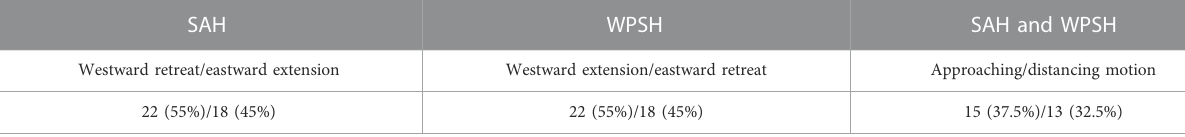
TABLE 2 Statistics of the ridge points and zonal relative position changes in the SAH and the WPSH. SAH WPSH SAH and WPSH Westward retreat/eastward extension Westward extension/eastward